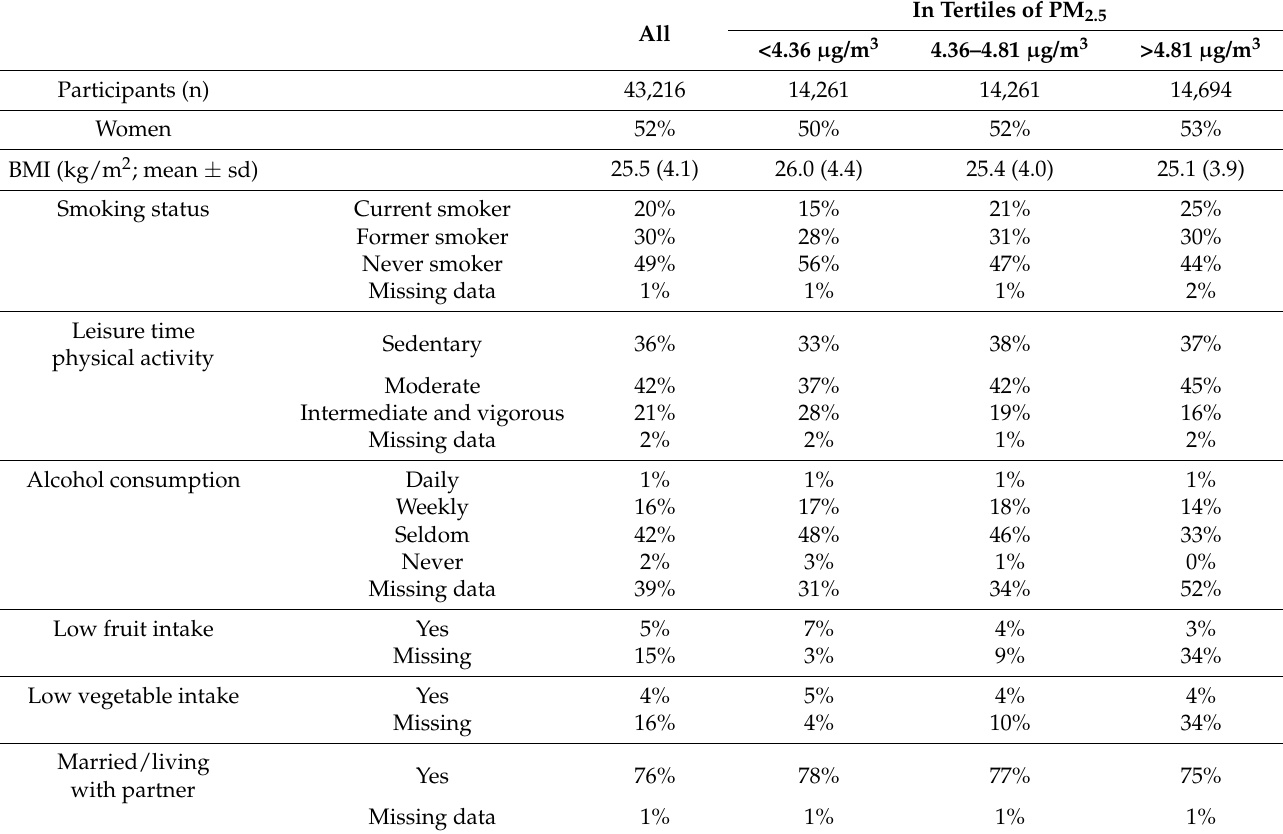
Table 1. Descriptive statistics of the study